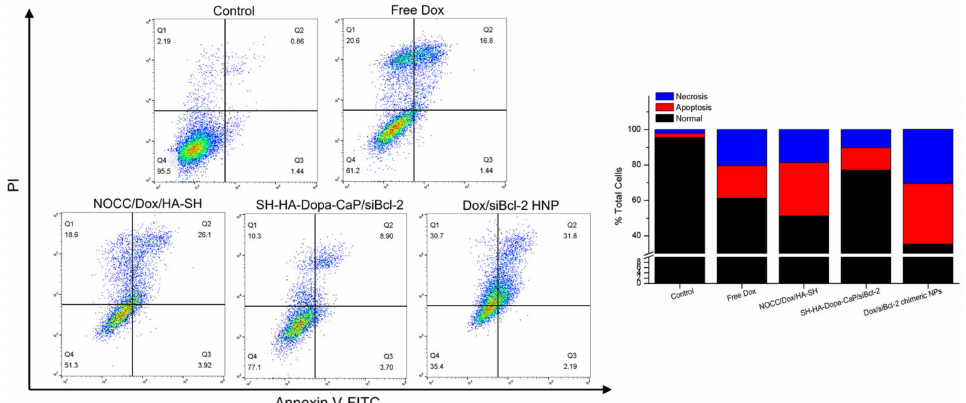
Figure 10. Flow cytometry analysis of OVCAR-3 cell apoptosis after different treatments using the Annexin V-FITC/PI assay and statistical analysis of normal, apoptotic, and necrotic cells. Data are shown as mean ± SD (n =